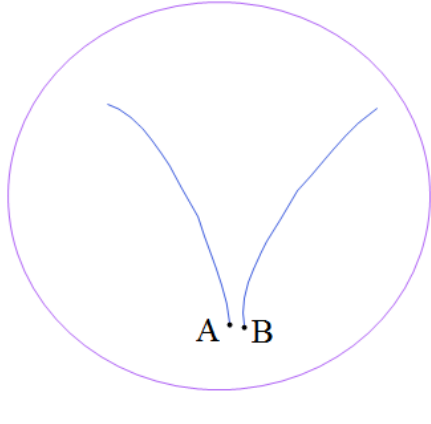
Figure 2. A pair of points and their trajectories on complexity geometry SU ( 2 K ) . They are initially arbitrarily close, i.e., low relative state complexity. At the scrambling time, however, their trajectories diverge, and the distance between them grows